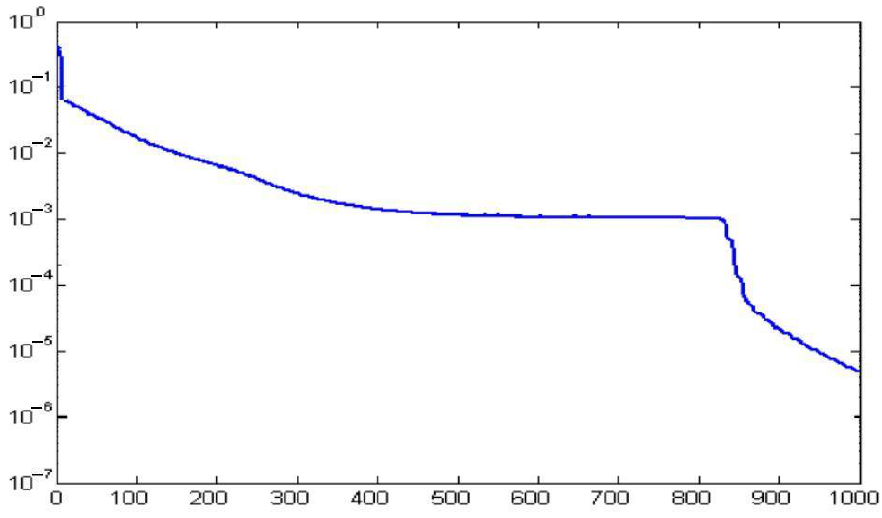
Figure 3. Values of mean square error (MSE) during learning.